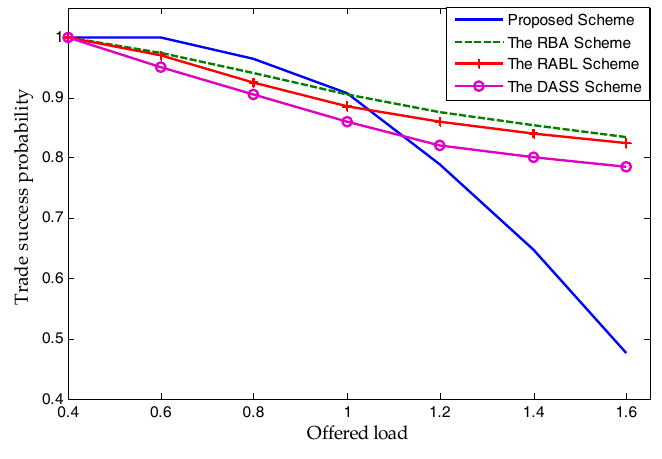
Proposed Scheme The RBA Scheme The RABL Scheme The DASS Scheme